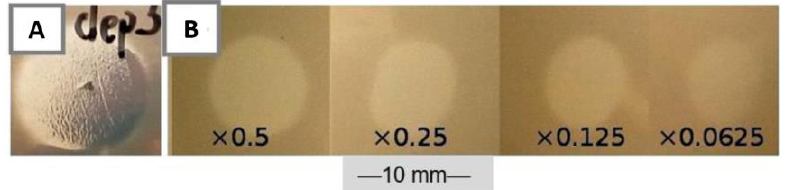
Figure 6. Capsule-degrading activity of B1dep. Spot tests of the purified recombinant B1dep protein on 52145 WT lawn. ( A ) Turbid spot of concentrated crude KRX lysate, resembling the plaque halo. ( B ) Spots of dilution series of purified B1dep. A total of 10 µ L was spotted from every dilution. Scale bar represents 10 mm.